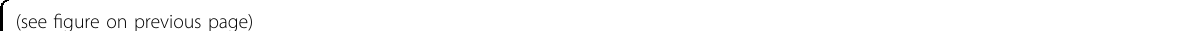
Fig. 3 FKBP39 associates with Nprl3 and promotes Nprl3 degradation. A S2 cells were co-transfected with HA-tagged Nprl3 and V5-tagged FKBP39 or lacZ (control) plasmids. Cells were lysed and immunoprecipitated using beads coated with anti-HA antibody. Cell lysates (inputs) and immunoprecipitates (IP) were detected by western blot. B S2 cells were co-transfected with HA-tagged Nprl3 and V5-tagged FKBP39 or lacZ (control) plasmids. Cells were cultured in Schneider ’ s medium plus 10% FBS (AA + ) or amino-acid-free Schneider ’ s medium (AA − ) for 2 h. The cells were lysed and immunoprecipitated using beads coated with an anti-HA antibody. Cell lysates (inputs) and immunoprecipitates (IP) were detected by western blot. C S2 cells were transfected with GFP (control) or fkbp39 dsRNA. Cells were treated with amino acid starvation for 2 h. The levels of Nprl3 were detected by western blot. D S2 cells were co-transfected with the GFP (control) or fkbp39 dsRNA, constructs expressed HA-tagged Nprl3 and V5 tagged lacZ. The levels of HA-Nprl3 and V5-lacZ were detected by western blot. V5-lacZ was used as a loading control for western blot. E S2 cells were co-transfected with the GFP (control) or fkbp39 dsRNA and construct expressed V5-tagged Nprl3. Cells were treated with amino acid starvation for the indicated hours. The levels of V5-Nprl3 were detected by western blot. F S2 cells were co-transfected with the GFP (control) or fkbp39 dsRNA and construct expressed V5-tagged Nprl3. The cells were treated with CHX for the indicated time and the V5-Nprl3 levels were measured by western blot. The remaining protein levels at each time point were calculated, taken the expression level of V5-Nprl3 at 0 h as 1. Error bars represent standard error values from three independent experiments. * P < 0.05. α -Tubulin was used as a loading control for western blot. Similar western blot results were observed in more than three independent experiments for each